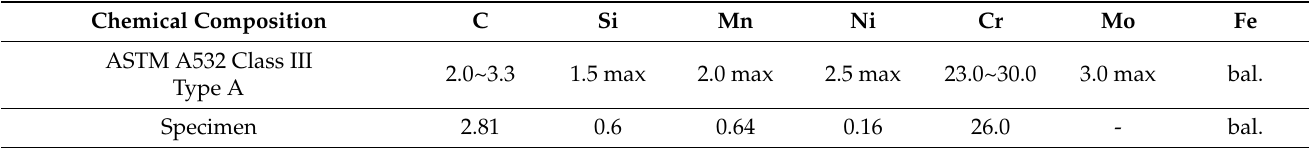
Table 1. Chemical composition of the specimen wt%.